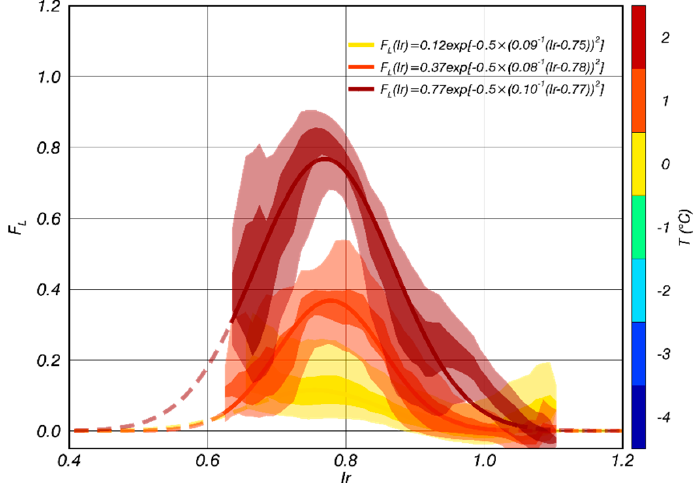
Figure 9. Color − shaded 2D histogram plots of Ir versus F L for each T class. The color shades correspond to the data range of ±10% and ±25% from the median value.